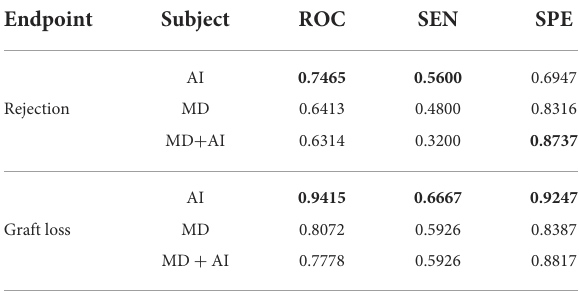
TABLE 3 AUC-ROC performance of junior and senior physician groups in both parts of the study.